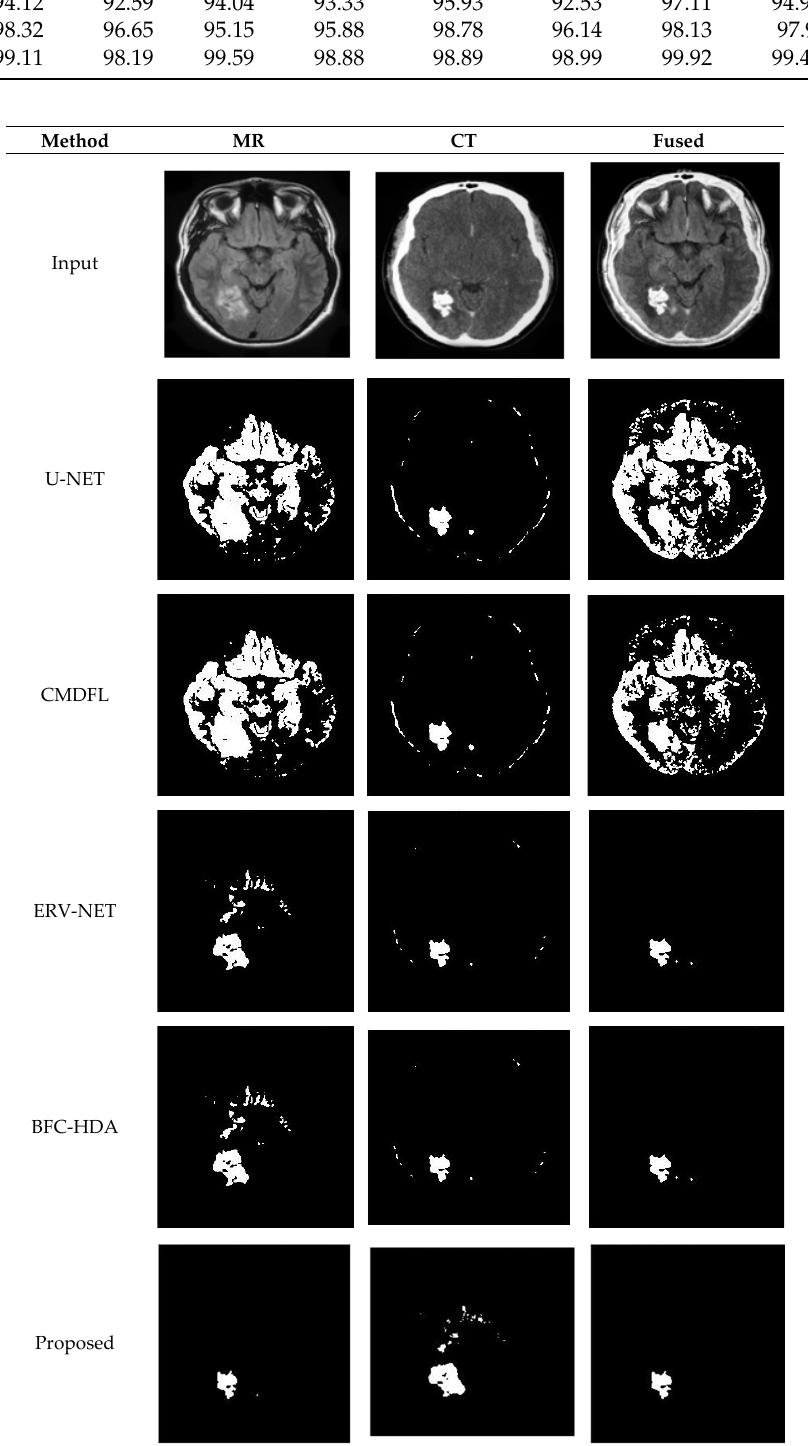
Figure 12. Segmentation performance comparison of MR, CT, and Fused images (U-NET [20], CMDFL [22], ERV-NET [23], BFC-HDA [27]).